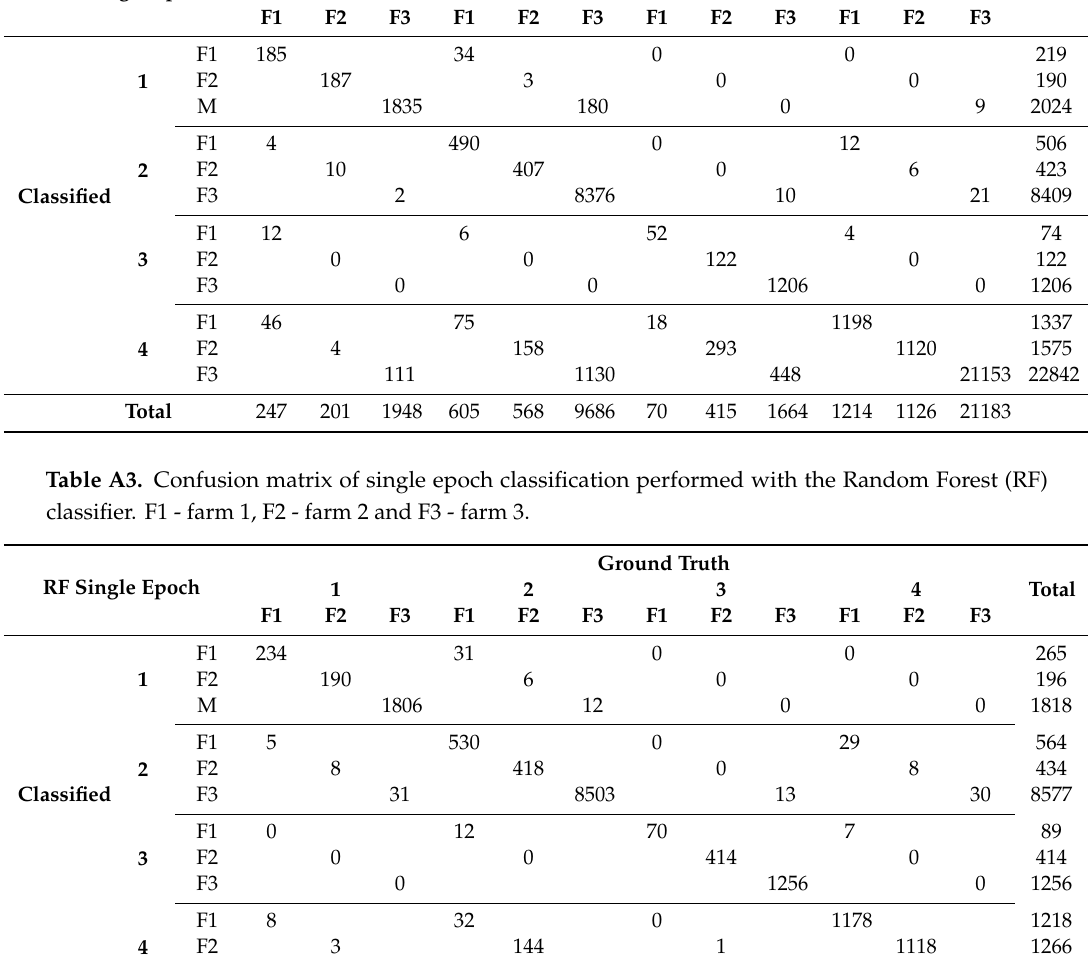
Table A2. Confusion matrix of single epoch classification performed with the Support Vector Machine (SVM) classifier, where F1 - farm 1, F2 - farm 2 and F3 - farm 3. SVM Single Epoch